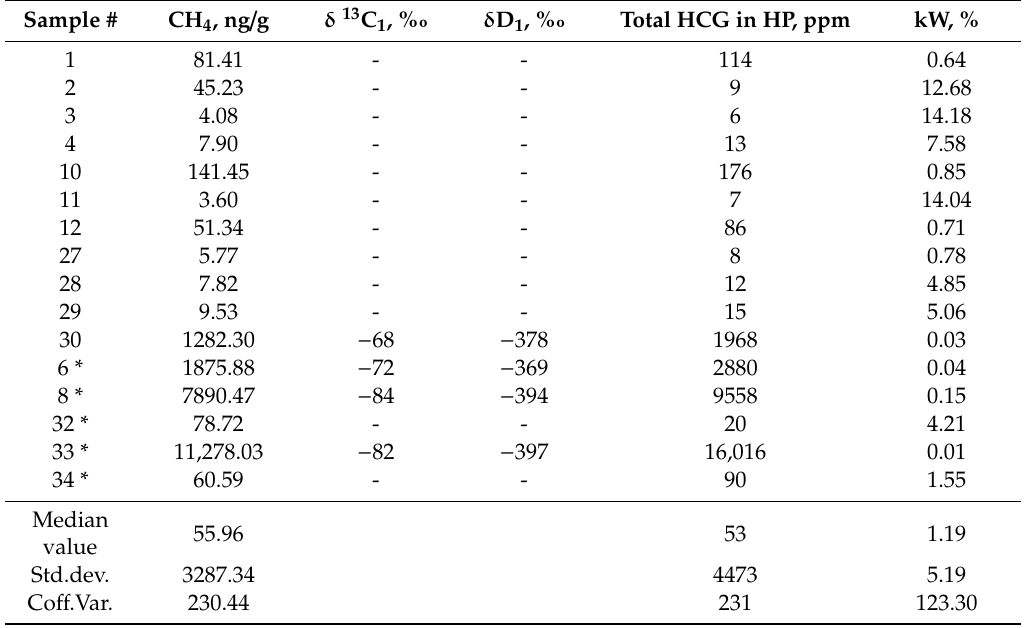
Table 3. CH 4 concentrations and isotope composition, parameters of C 1 –C 5 HG molecular